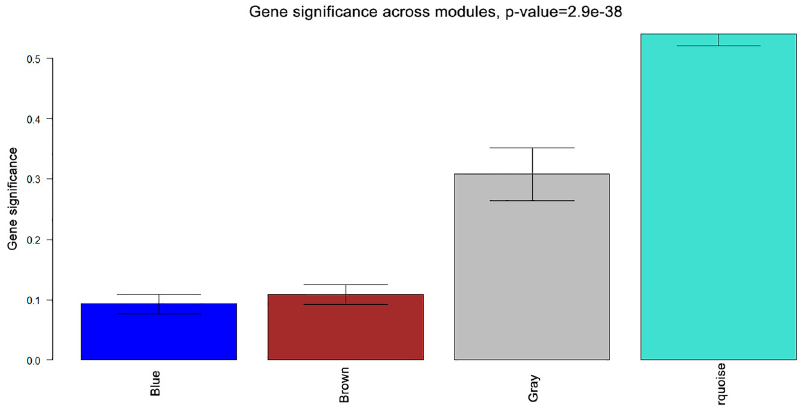
Figure 3: Heatmap showing expression profiles: expression levels in miRNA modules (left) and expression levels in gene modules (right).